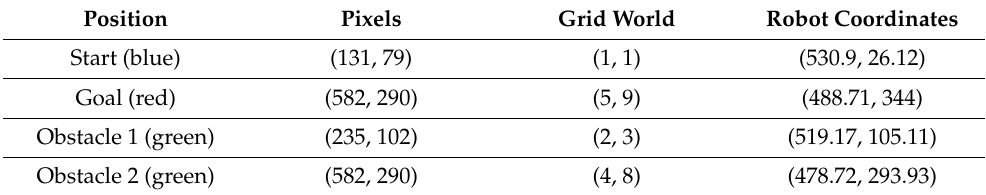
Table 1. Transformed Coordinates of Colored Objects Placed in Robot Workspace.